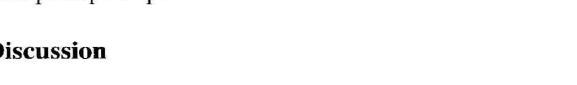
Fig. 3 reflects the influence of isoxanthopterin (5 and 30 pmoljg wet weight) on phospholi pid biosynthesis in vitro. The addition of isox